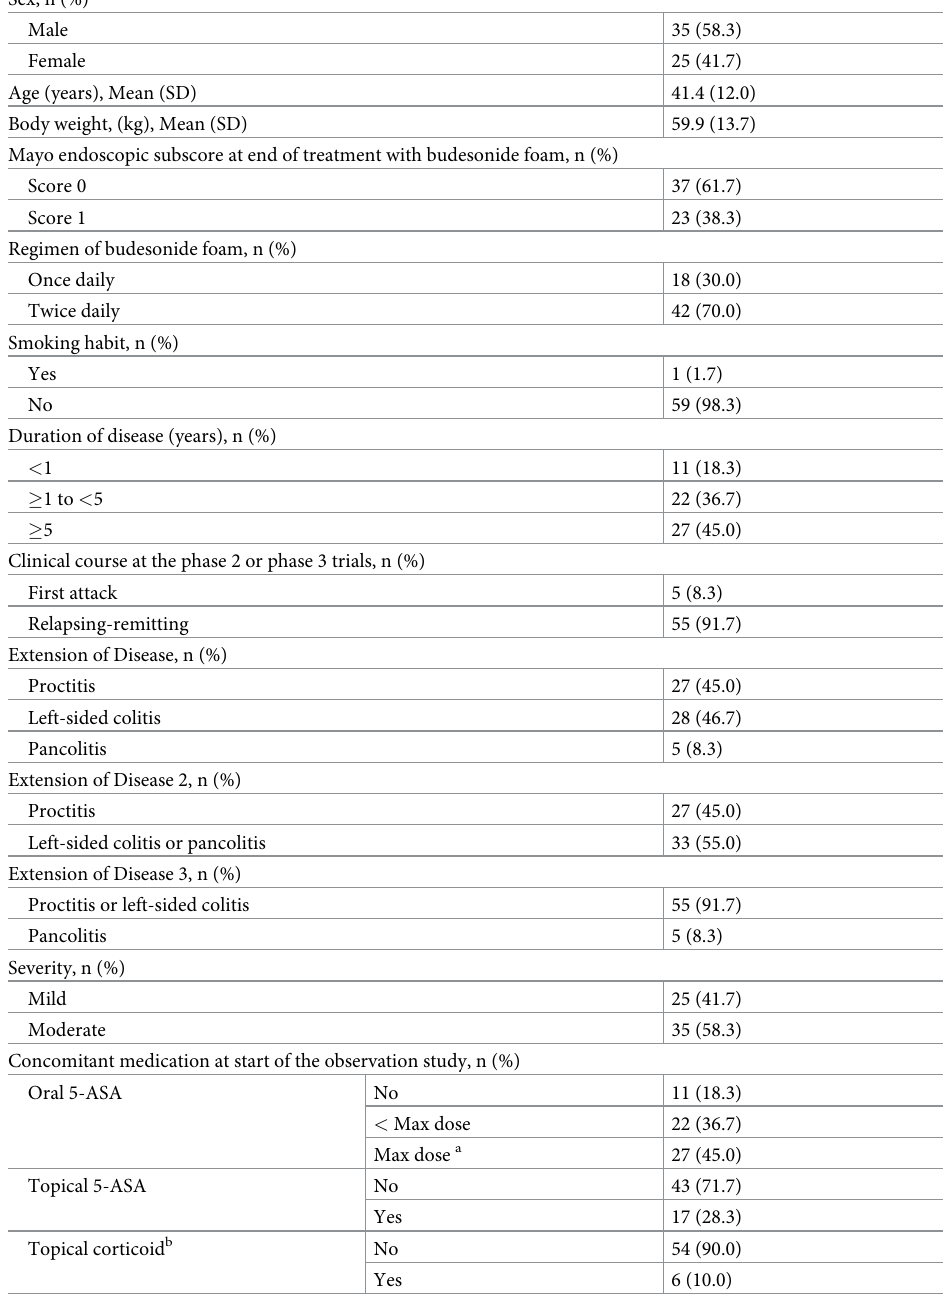
Table 1. Patient demographics and baseline characteristics (analysis